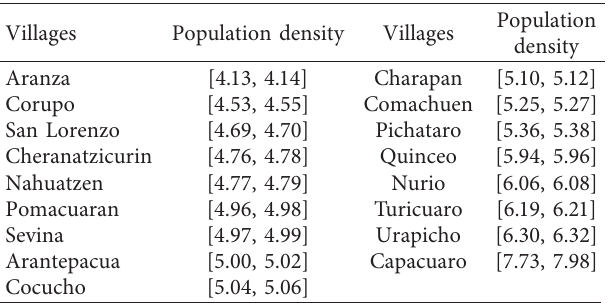
Figure 9: Comparison of the proposed test and the existing test for neutrosophic Cauchy distribution. Table 5: The neutrosophic